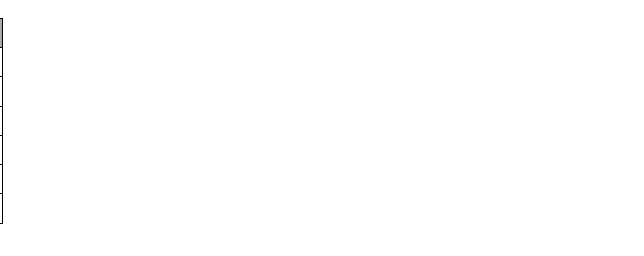
Table 2. Mecanum wheel